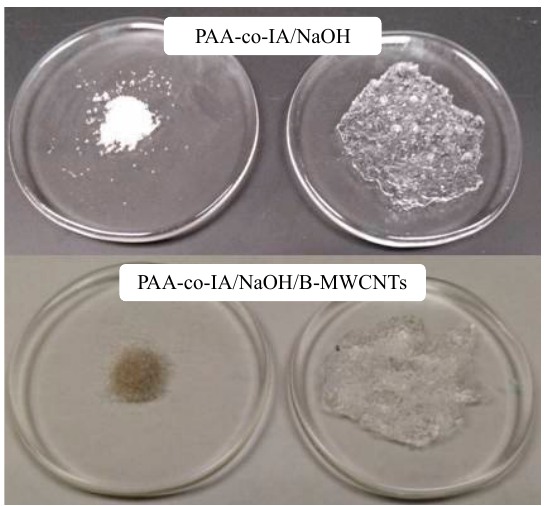
Figure 1. Images of dry and swollen PAA-co-IA/NaoH and PAA-co-IA/NaOH/B-MWCNTs hydrogels.